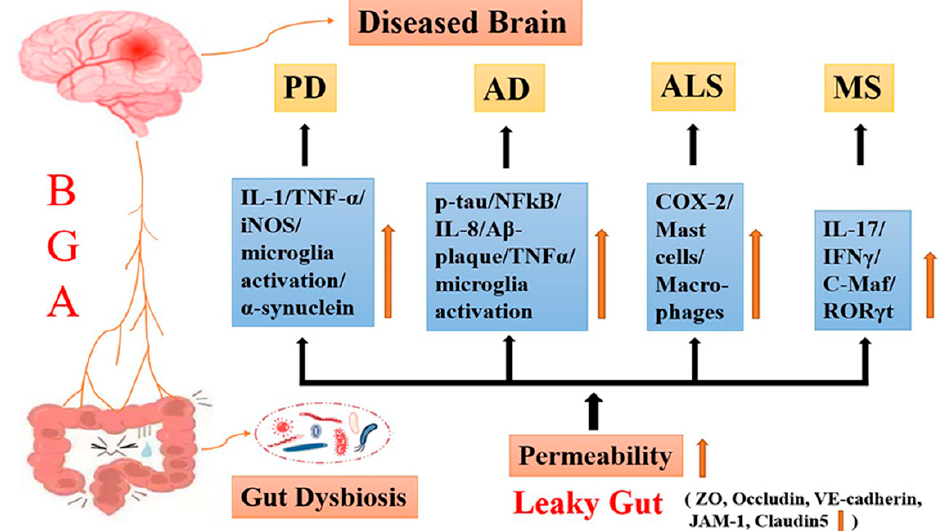
Figure 2. Diagrammatic representation of the gut dysbiosis leads to the development of neurodegenerative diseases and their potential mechanisms through activation of inflammatory path- ways.